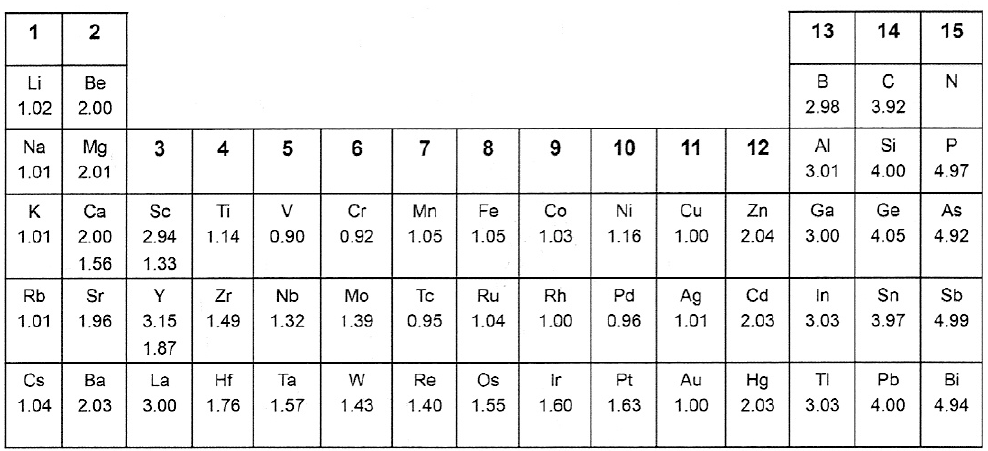
Figure 4. Electron per atom concentration ratio e / a for 54 elements in the periodic table. The value in the top (bottom) level for Ca, Sc, and Y is used when these atoms are alloyed with non-transition metal (transition metal) elements, respectively. (Reprinted from Mizutani U and Sato H, The physics of the Hume-Rothery electron concentration rule, Crystals 7, 9 (2017); doi:10.3390 / cryst7010009,